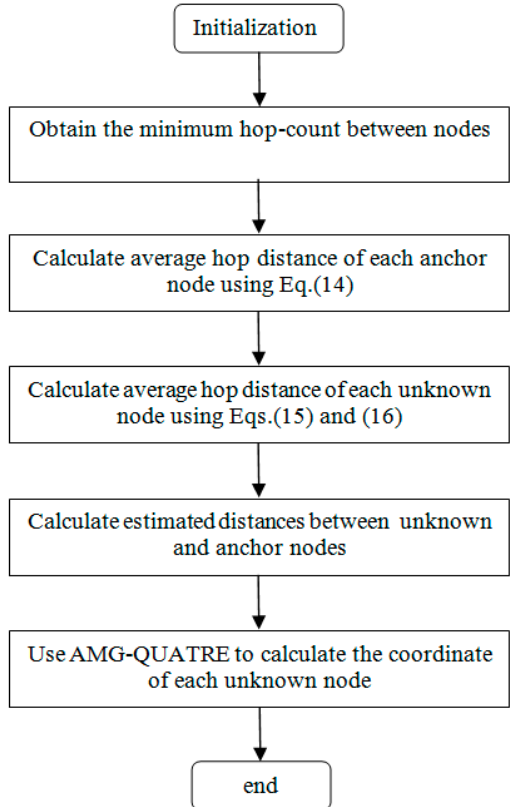
Figure 2. Figure 2. The flowchart of the proposed distance vector-hop (DV-Hop) algorithm based on AMG-QUATRE.